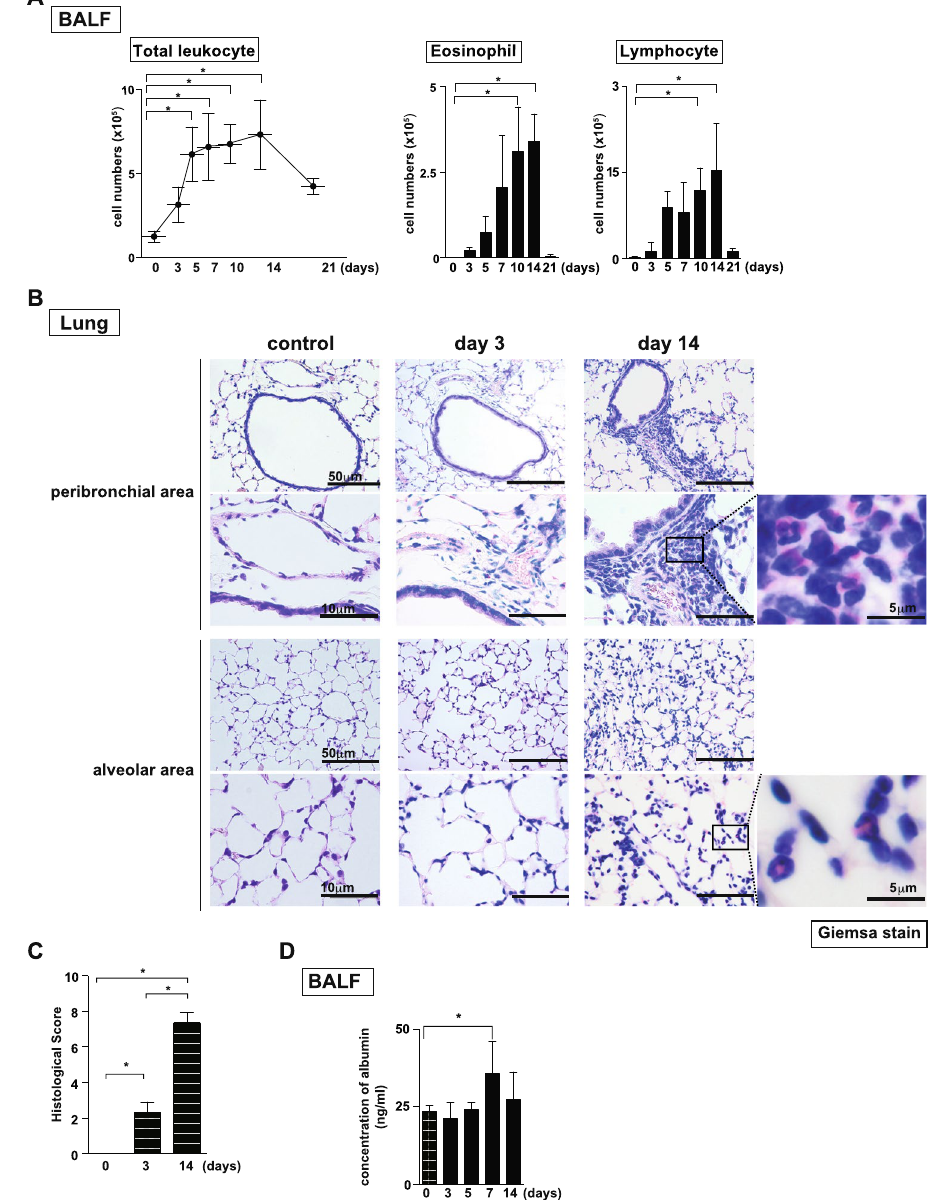
Figure 2. Intratracheal administration of IL-33 induced infiltration of eosinophils in the lung. IL-33 or saline (control) was administered intratracheally to BALB/c mice on Day 0, and the indicated assays were performed on Days 3 to 14. ( A ) The BAL fluid was assessed at the indicated time point. The numbers of total leukocytes (left), eosinophils (middle), and lymphocytes (right) in the BAL fluid are shown. ( B ) Microscopic pictures of the lungs from mice as in A , fixed and stained with Giemsa reagent. Scale bars: 50 μ m (top and 3 rd line), 10 μ m (2 nd and bottom line) and 5 μ m (right panel of 2 nd and bottom line). ( C ) Histological scores from Giemsa-stained samples are depicted. ( D) The vascular permeability was determined by the concentration of albumin in BAL fluid. Representative data were obtained from four independent experiments. Mean values ± SD are shown for ( A) and ( D) . * p < 0.05: one-way